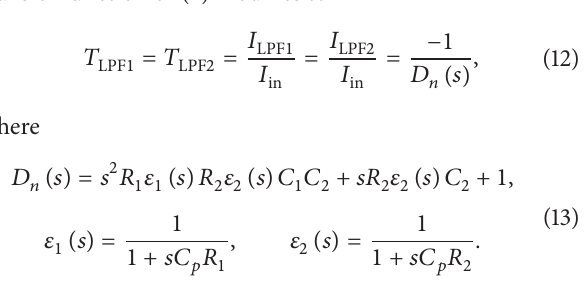
Figure 4: MOS realization of a resistor